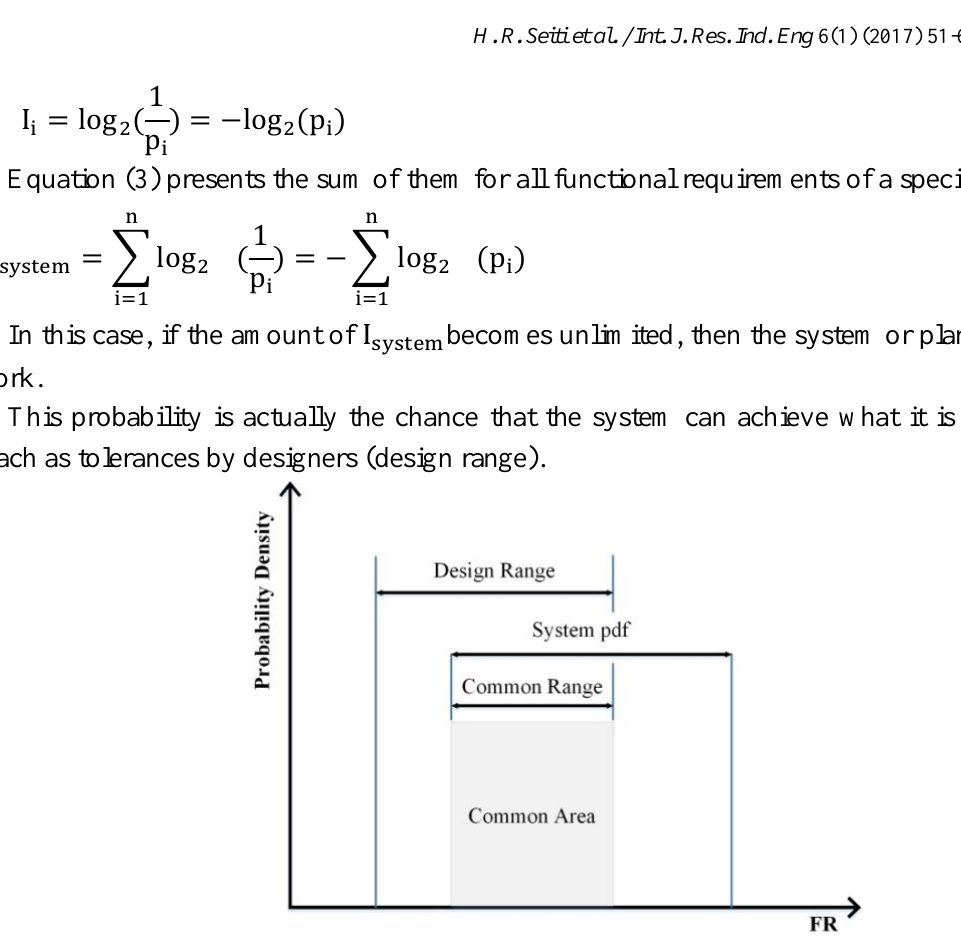
Figure 1. Assumption of uniform probability density function for design range and system